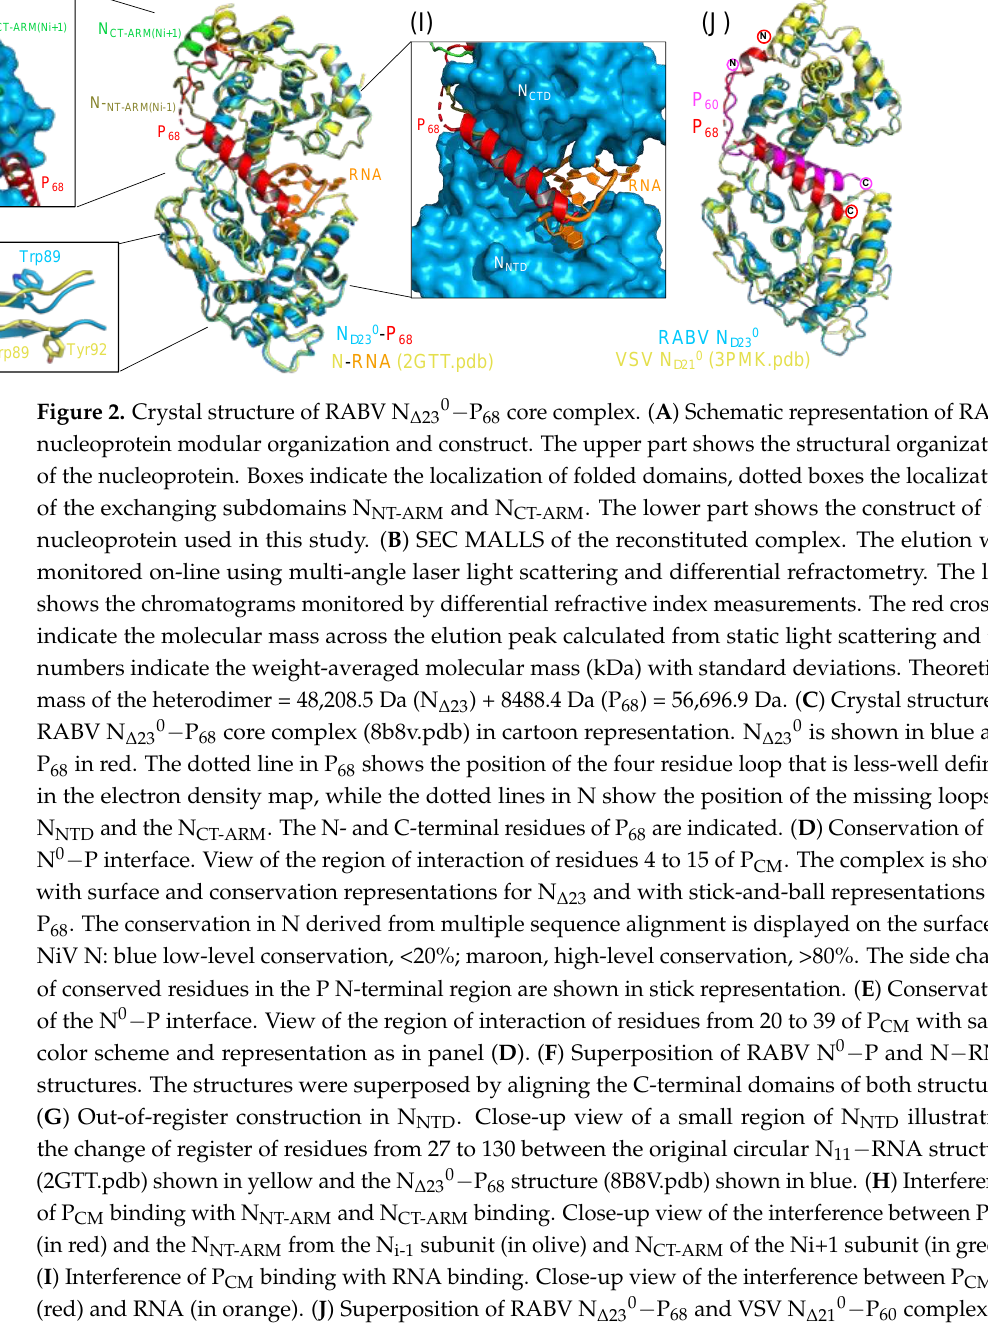
10 of 28 The structural alignments using PDBeFold showed that N CTD in our refined N  − P  structure was similar to that in the N − RNA complex [39] (RMSD = 0.84 Å) (Figure 2F), while the N NTD exhibited some differences with residues from 35 to 103 and from 189 to 200 being out-of-register in the structural alignment despite an RMSD of 0.95 Å (Figure